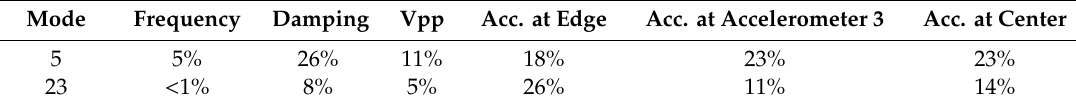
Table 7. Percentage of variation for test repetitions for mode 5 and 23.